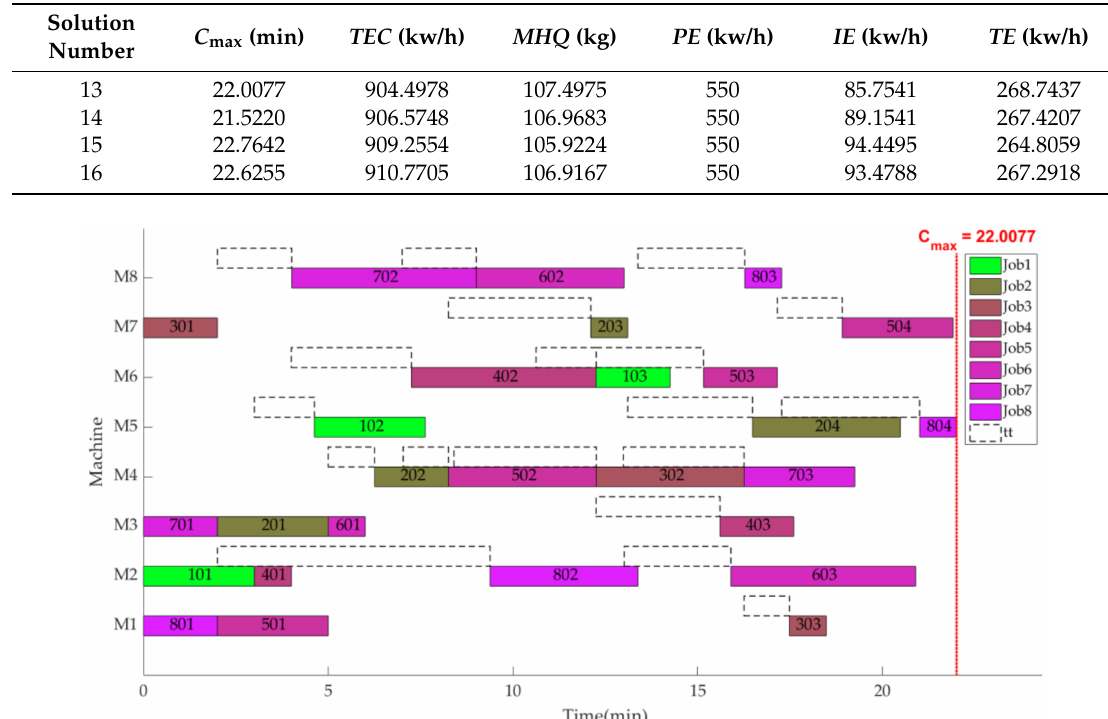
Figure 17. The Gantt chart of solution 13.